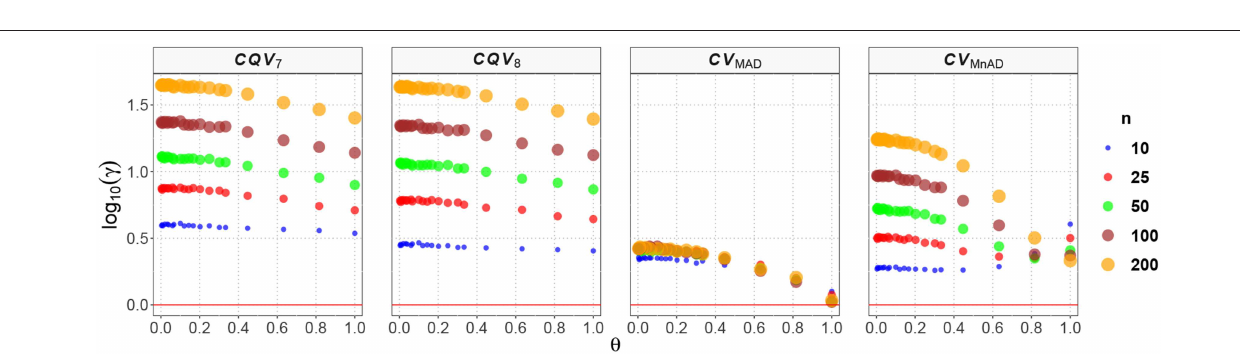
(0,1) produced for each estimator and sample size under the reparametrized ∈